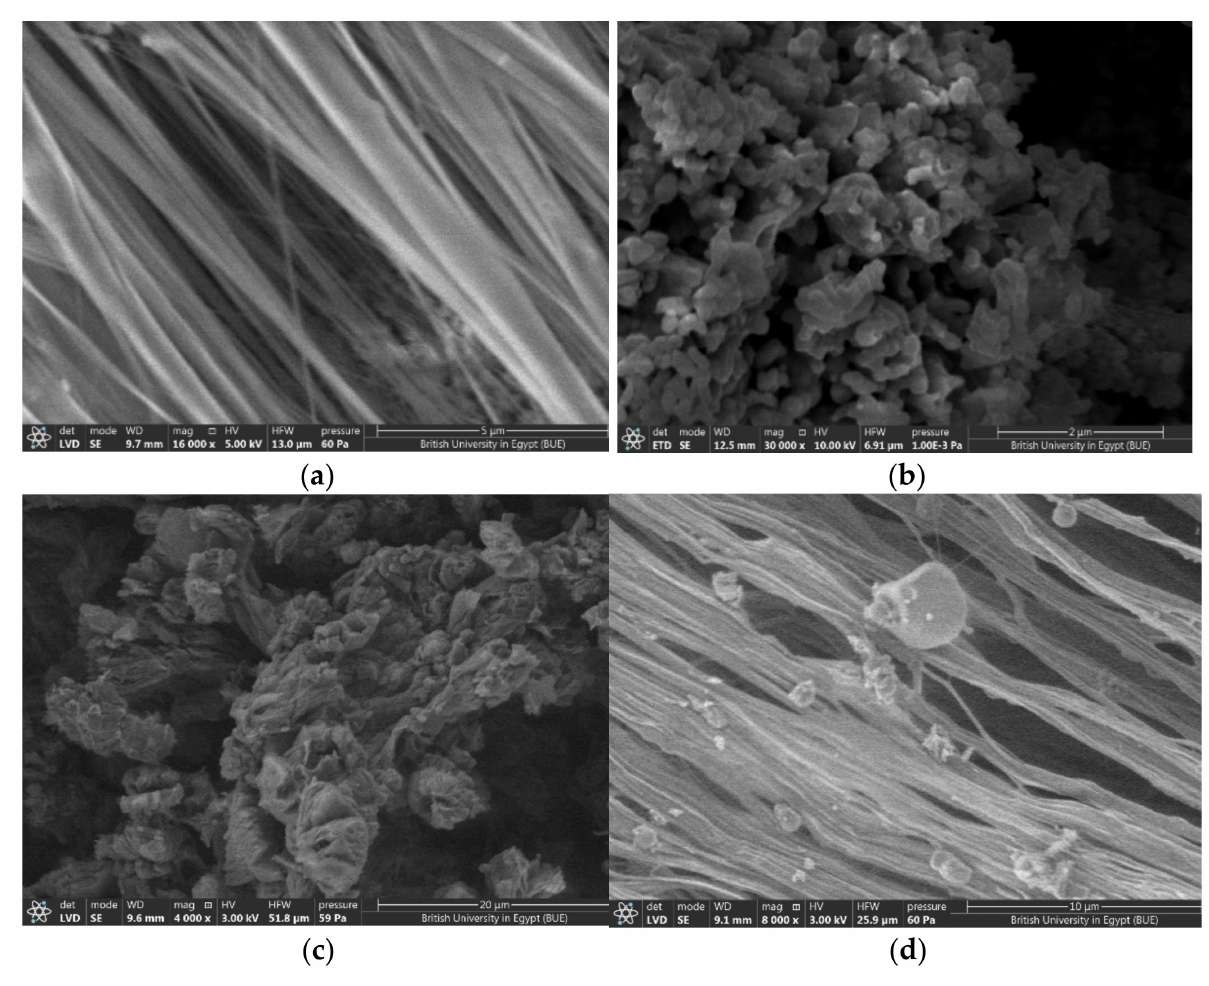
Figure 3. FESEM of ( a ) PTFE, ( b ) CuO, ( c ) G and ( d ) PTFE/CuO/G composite samples.